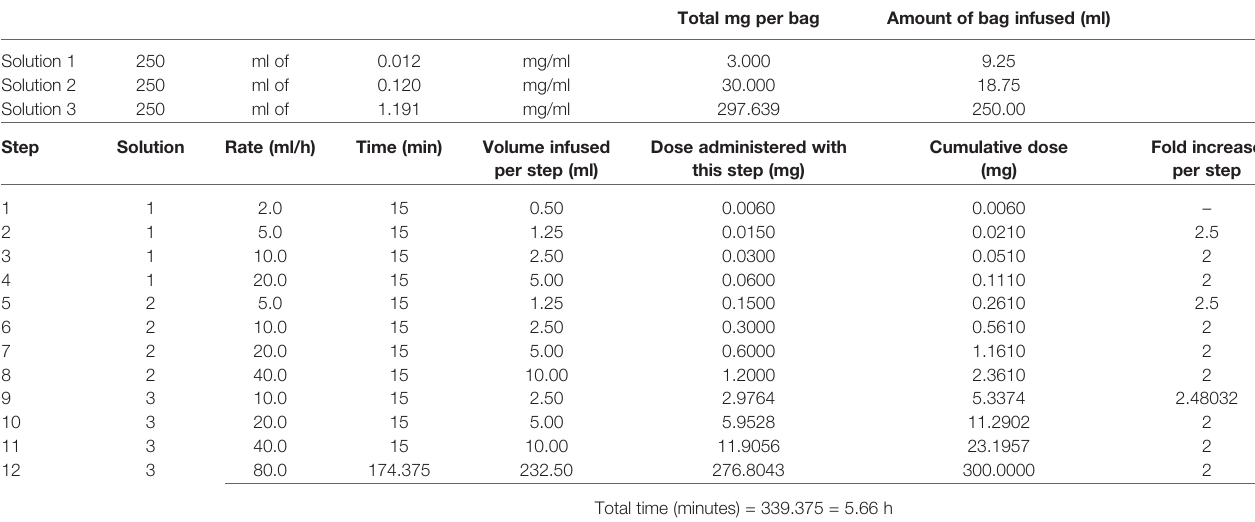
TABLE 1 | First rapid desensitization with Ocrelizumab 300 mg using the 3-bag, 12-step protocol published elsewhere